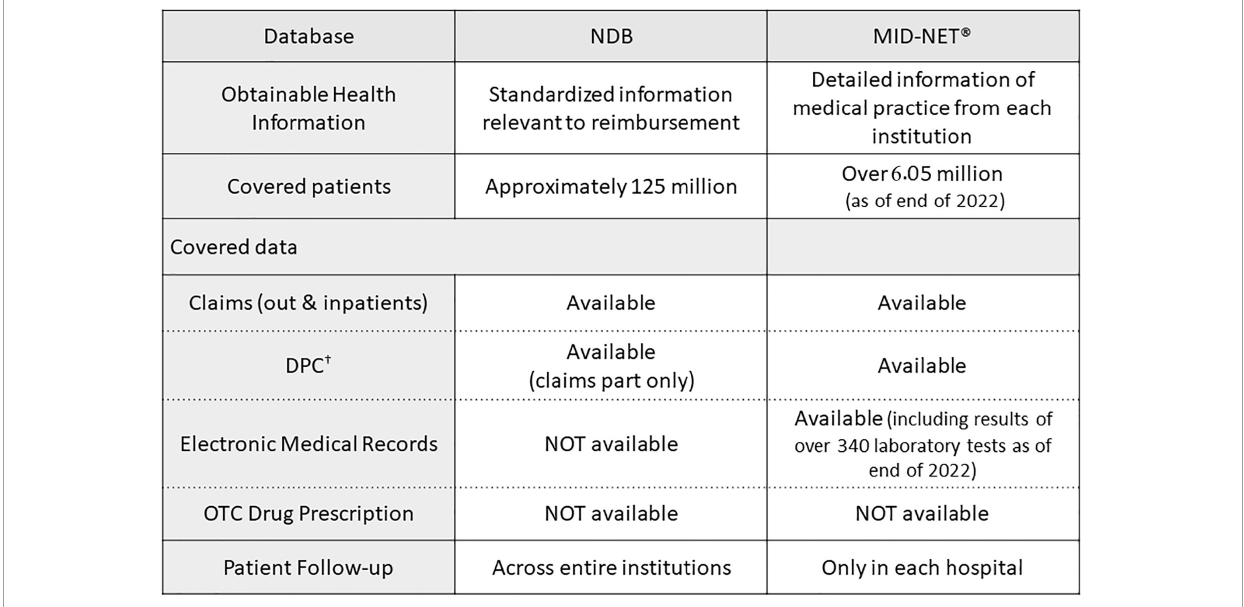
for ophthalmic use,” and “ophthalmic fluoroquinolones”).